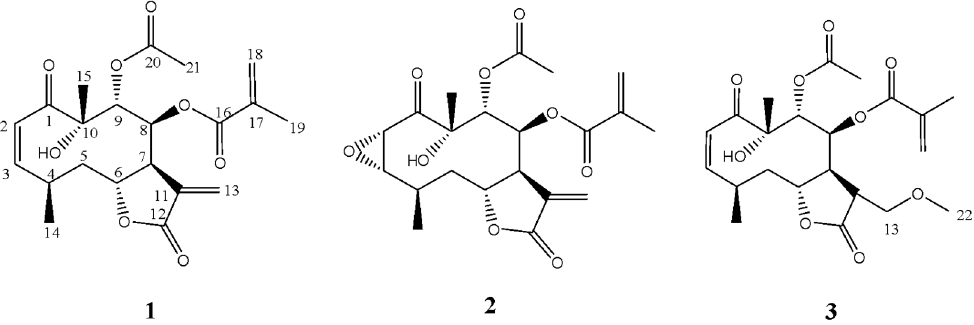
Figure 1. Structures of calein C ( 1 ), calealactone B ( 2 ) and the derivative of calein C ( 3 ).